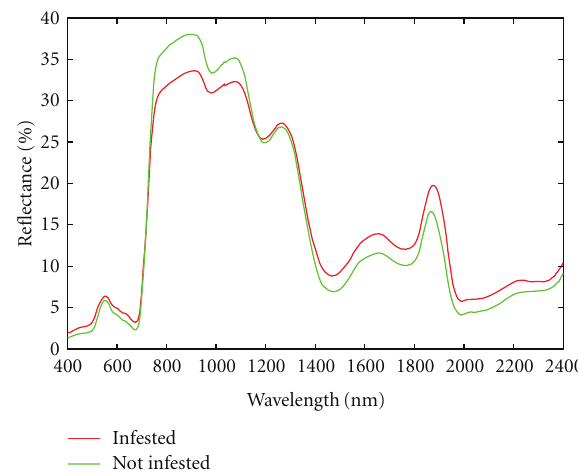
Figure 1: Mean spectral signatures of foliage from subalpine fir trees in the intermountain west measured using a ground-based spectroradiometer for trees that were not infested ( n = 84) or infested ( n = 122) with the balsam woolly adelgid.